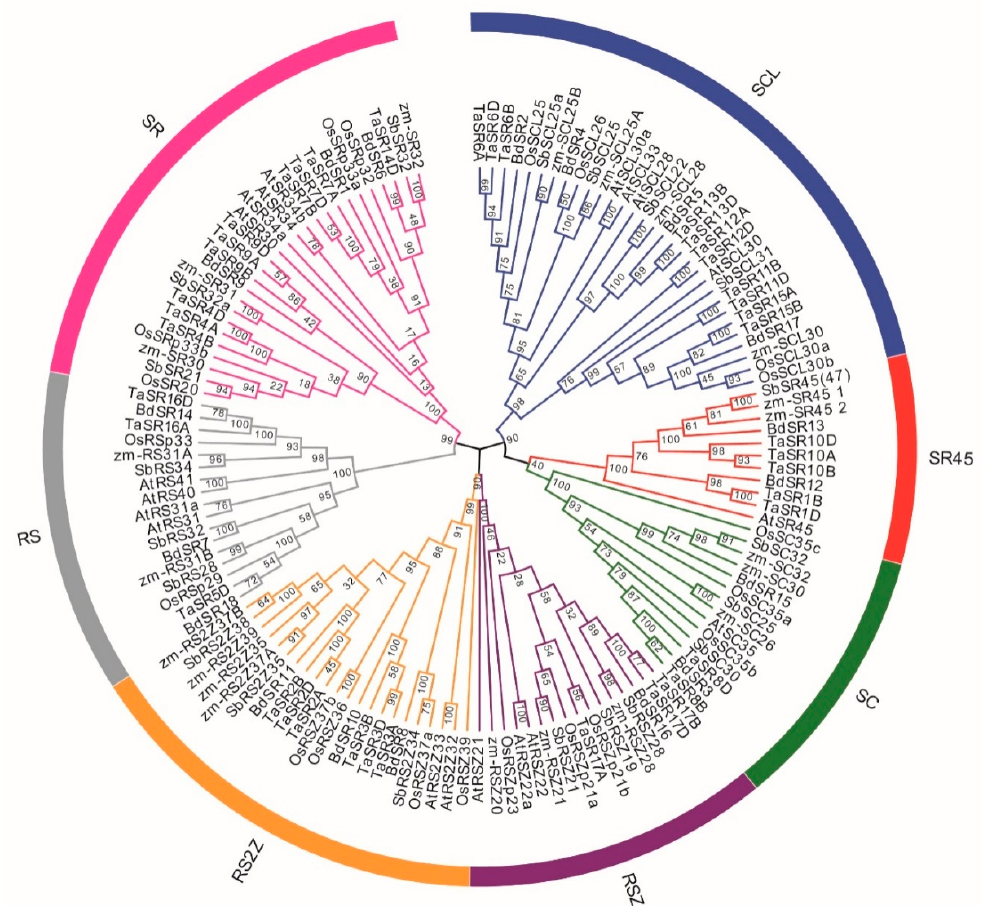
Figure 2. Phylogenetic tree of 138 plant SR proteins. The different colors indicate different subfamilies. Os, Sb, Zm, At, Bd, and Ta represent rice, Sorghum bicolor , Z. mays , Arabidopsis , B. distachyon , and wheat respectively.